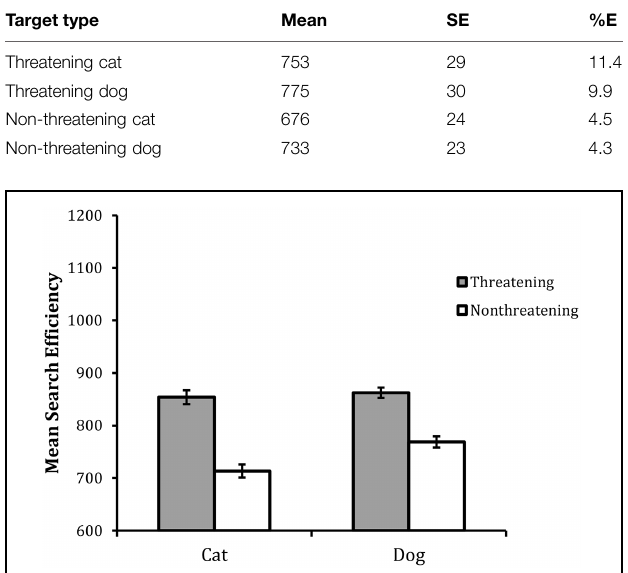
FIGURE 5 | Mean search efficiency scores as a function of target type in Experiment 3. Error bars reflect within-participant SE after variation between participants was removed (after Bakeman and McArthur,